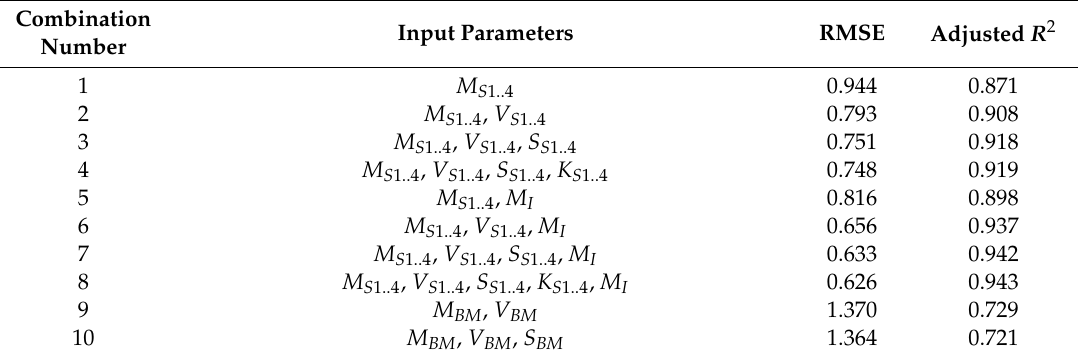
Table 2. Data for di ff erent combinations of input parameters for prediction of denoising e ffi ciency for